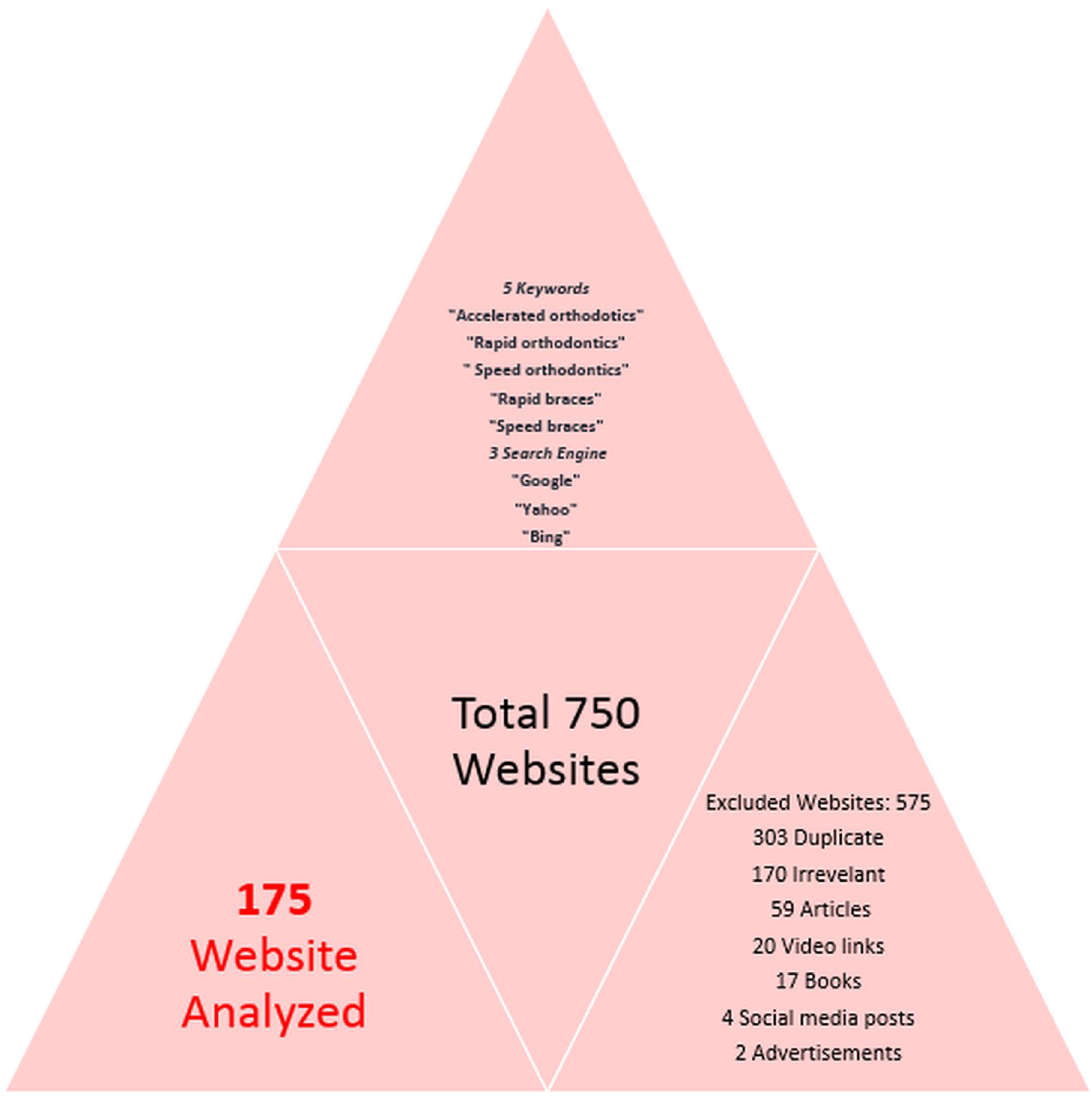
Figure 1. Website